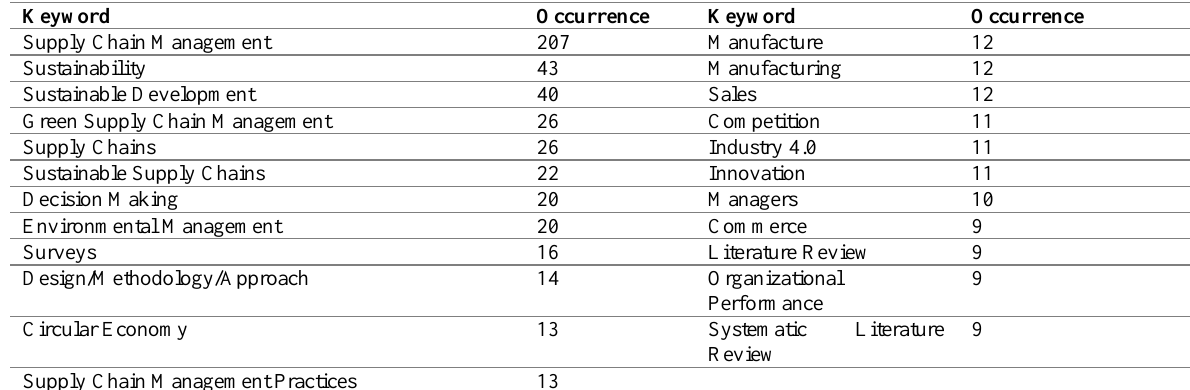
Figure 5 : Co-Occurrence of keywords; Source: Research data (2021) Table 11 : Most Frequently used